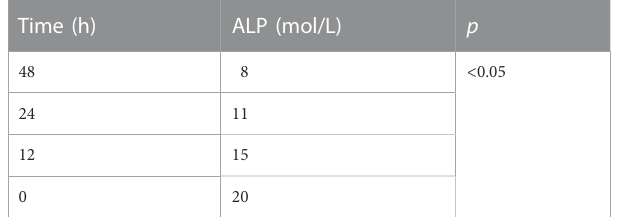
TABLE 2 Comparison of